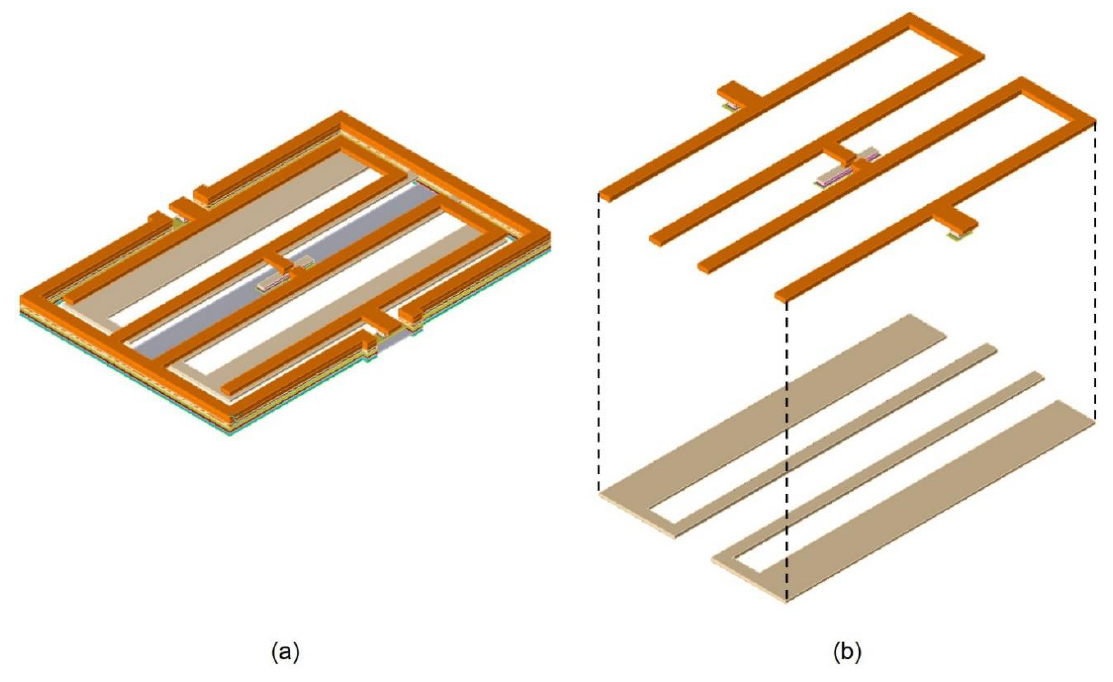
Figure 4. Layout of ( a ) proposed filter, ( b ) two topmost metal traces without ground.